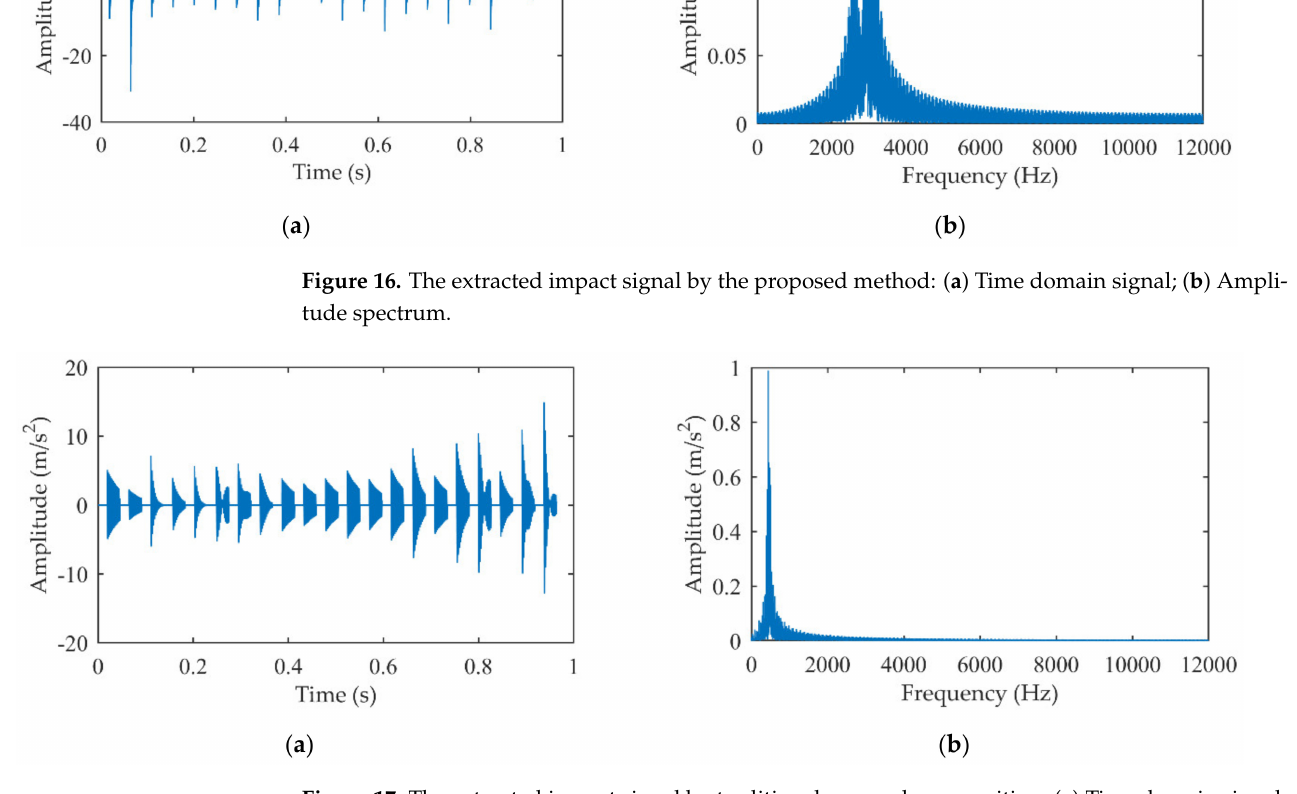
Figure 17. The extracted impact signal by traditional sparse decomposition: ( a ) Time domain signal; ( b ) Amplitude spectrum.